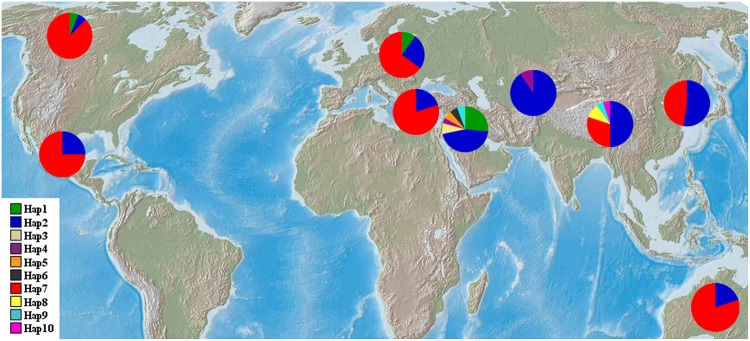
Geographic distribution of wild barley populations and landrace populations.
NAM-1 haplotype frequencies among nine geographic regions were displayed in pie diagrams and the exact proportions of each are given in percent by the corresponding color code.